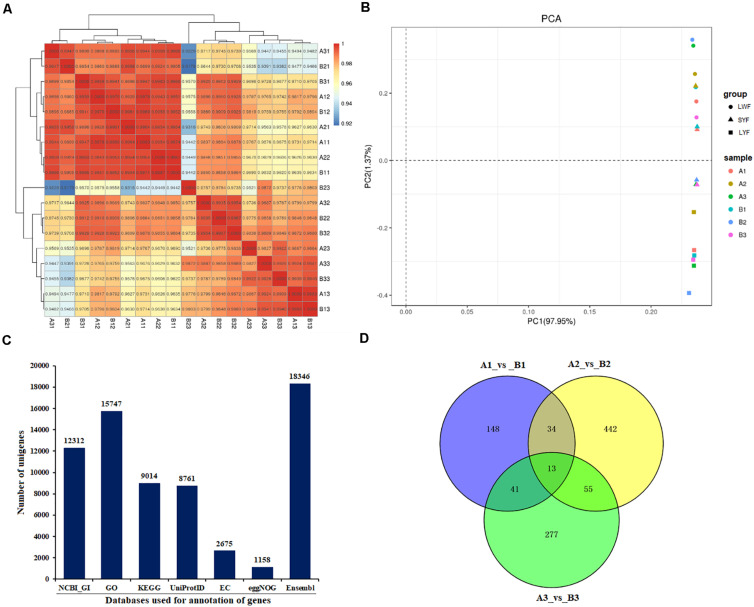
Basic information of sequencing data. (A) Pairwise Pearson’s correlation coefficients of sequencing data from six samples with three replicates; (B) Principal component analysis (PCA) of transcriptomic variation. Shapes denote different groups of the follicles sampled, colored dots indicate different samples; (C) annotation of gene numbers based on different databases; (D) Venn diagram analysis of distribution of annotated genes of different follicle groups of HR and LR hens. A1, LWF of HR hens; B1, LWF of LR hens; A2, SYF of HR hens; B2, SYF of LR hens; A3, LYF of HR hens; B3, LYF of LR hens.